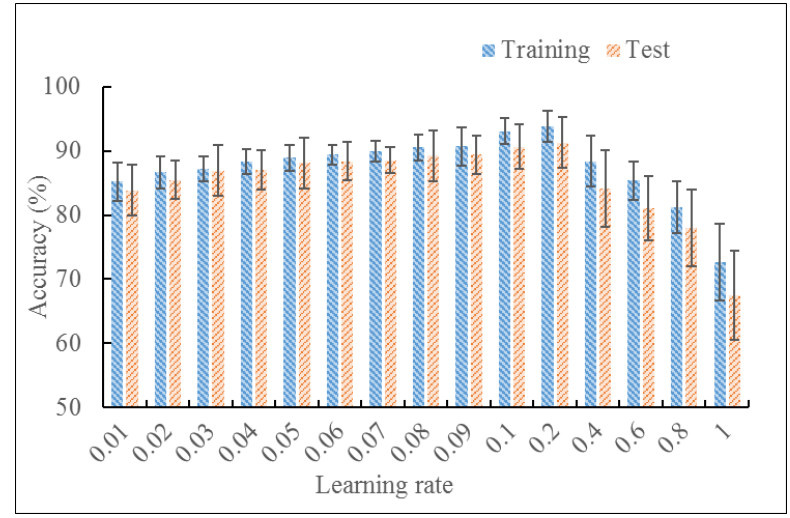
12 of 17 Figure 12. Recognition rate under different noise rates. 3.3.4. Learning Rate